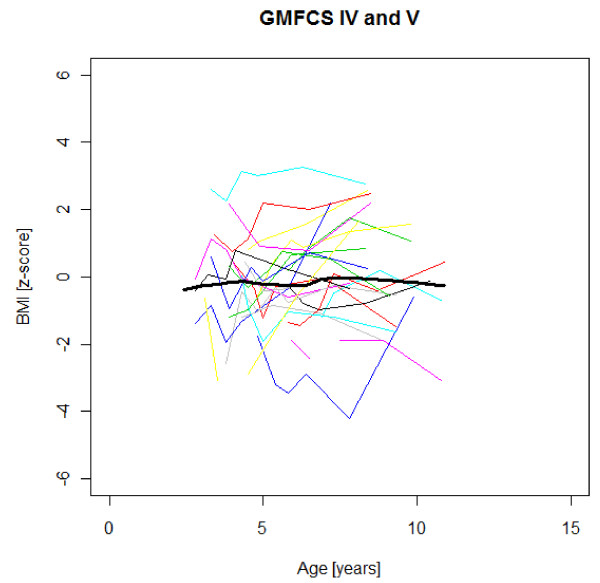
BMI z-scores in GMFCS IV-V. BMI z-score at different age in 24 children with CP spastic diplegia, GMFCS IV-V. Their mean z-score development with age is shown in black.